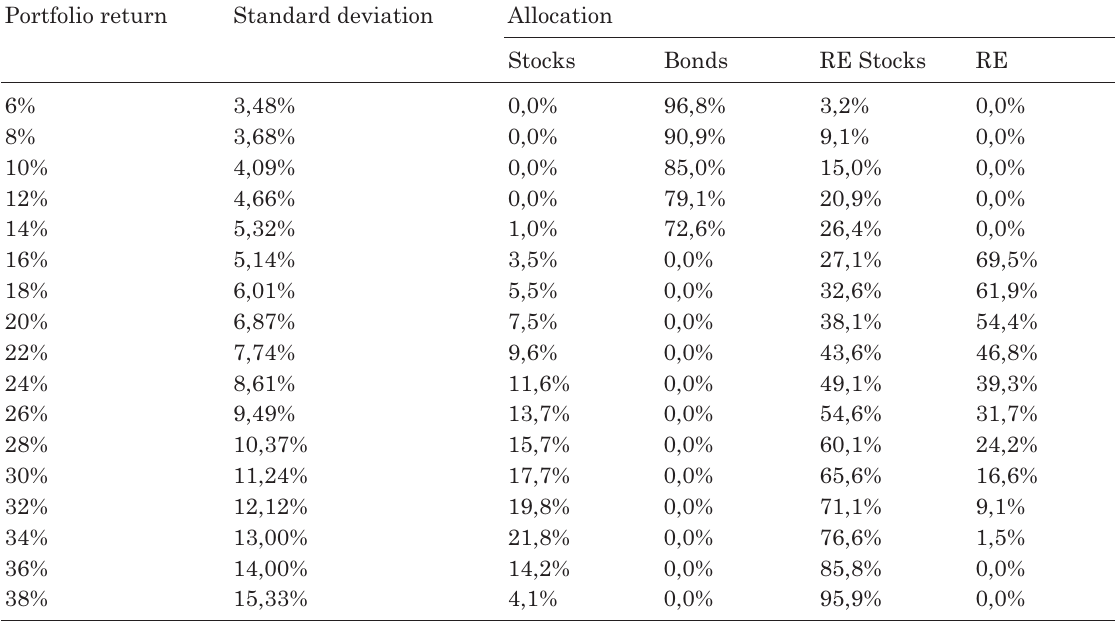
Table 2. Asset allocation in effi cient mixed-asset portfolios Portfolio